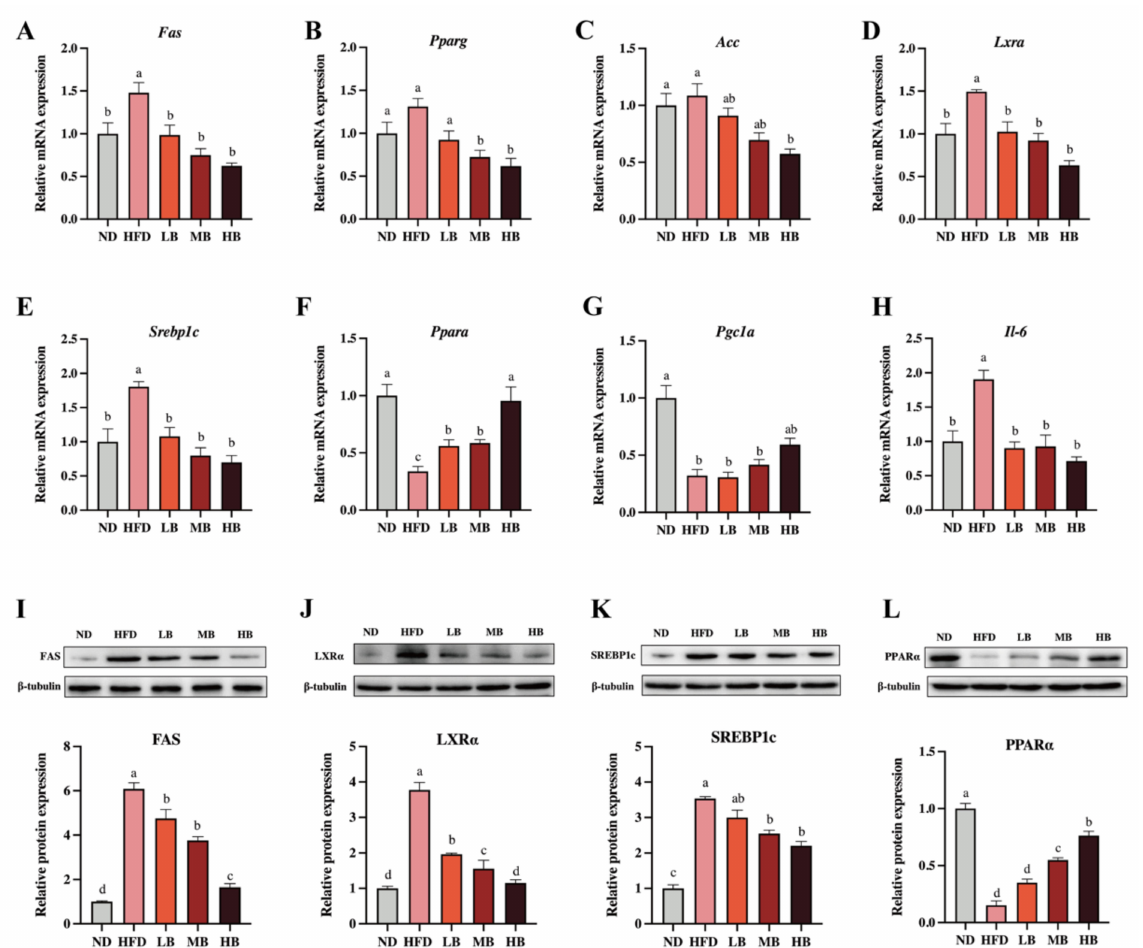
Figure 4. Effects of tartary buckwheat on the expression of genes and proteins linked to lipid metabolism. ( A – H ) The relative mRNA expression of hepatic Fas , Pparg , Acc , Lxra , Srebp1c , Ppara , Pgc1a , and Il-6 . ( I – L ) Western blot images and the protein expression of hepatic FAS, LXR α , SREBP-1c, and PPAR α . Data are expressed as the mean ± SEM ( n = 8). The mean value with different letters indicates significant differences ( p <